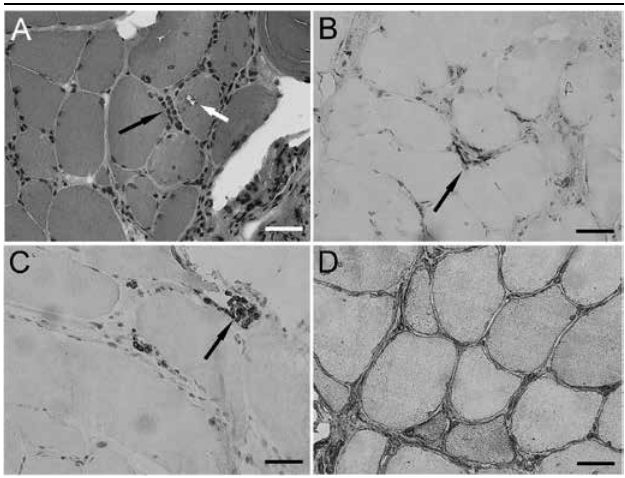
figurE 2 – Deltoid muscle biopsy: A) hematoxylin and eosin staining showing endomysial inflammatory reaction (black arrow) besides muscle fibers with rimmed vacuoles (white arrow). The peroxidase-IH reaction demonstrated an increase of staining for inflammatory markers CD68 (to identify macrophages) (arrow); B) and CD8 (to identify CD8-lymphocytes) (arrow); C) and diffuse increased expression of the major histocompatibility complex class I; D) lens = 40×; bars = 50 µm IH: immunohistochemical.